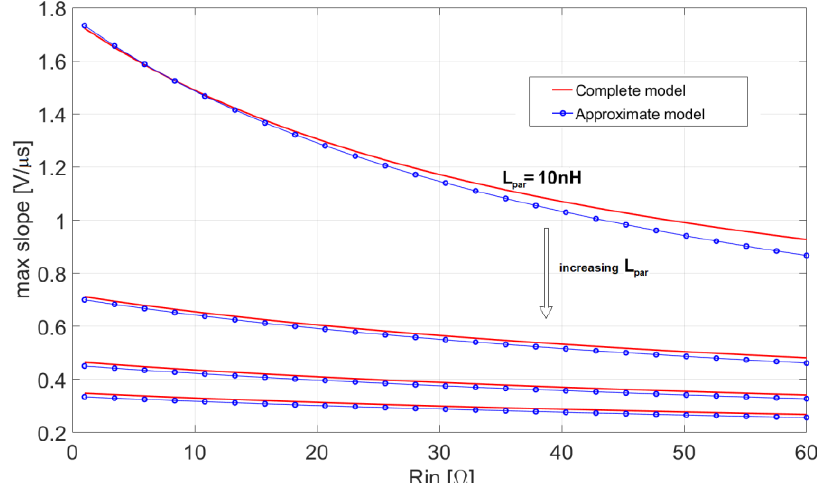
Figure 8. Maximum slope of the leading edge of the output pulse for the current-mode approach (12), compared with its approximation (21), with L par = 10 nH, 40 nH, 70 nH, 100 nH, C in = 0.5 pF and BW = 0.5 GHz.